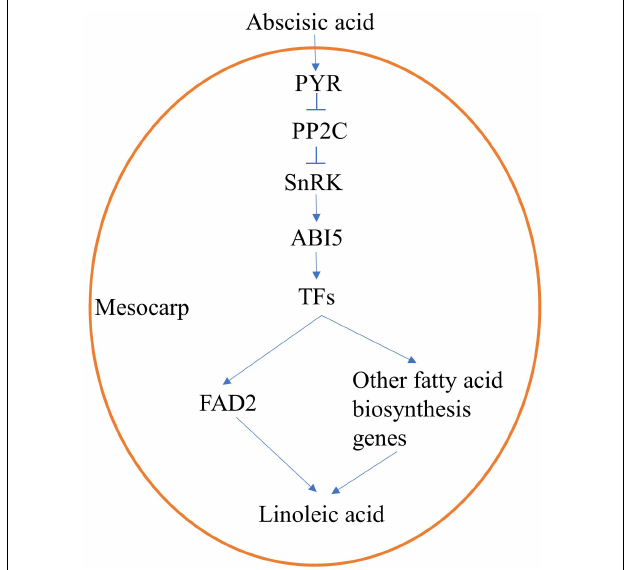
FIGURE 8 | An speculative regulation mechanism of ABA-promoting linoleic acid biosynthesis in oil palm mesocarp.